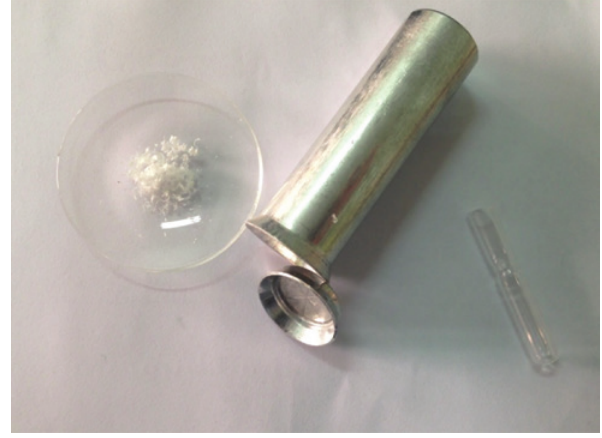
Figure 2: Equipment for introducing neat cured epoxy to reactor core.